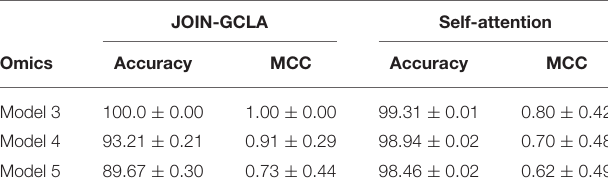
TABLE 9 | Ablation study of the attention layer on DTI-fMRI